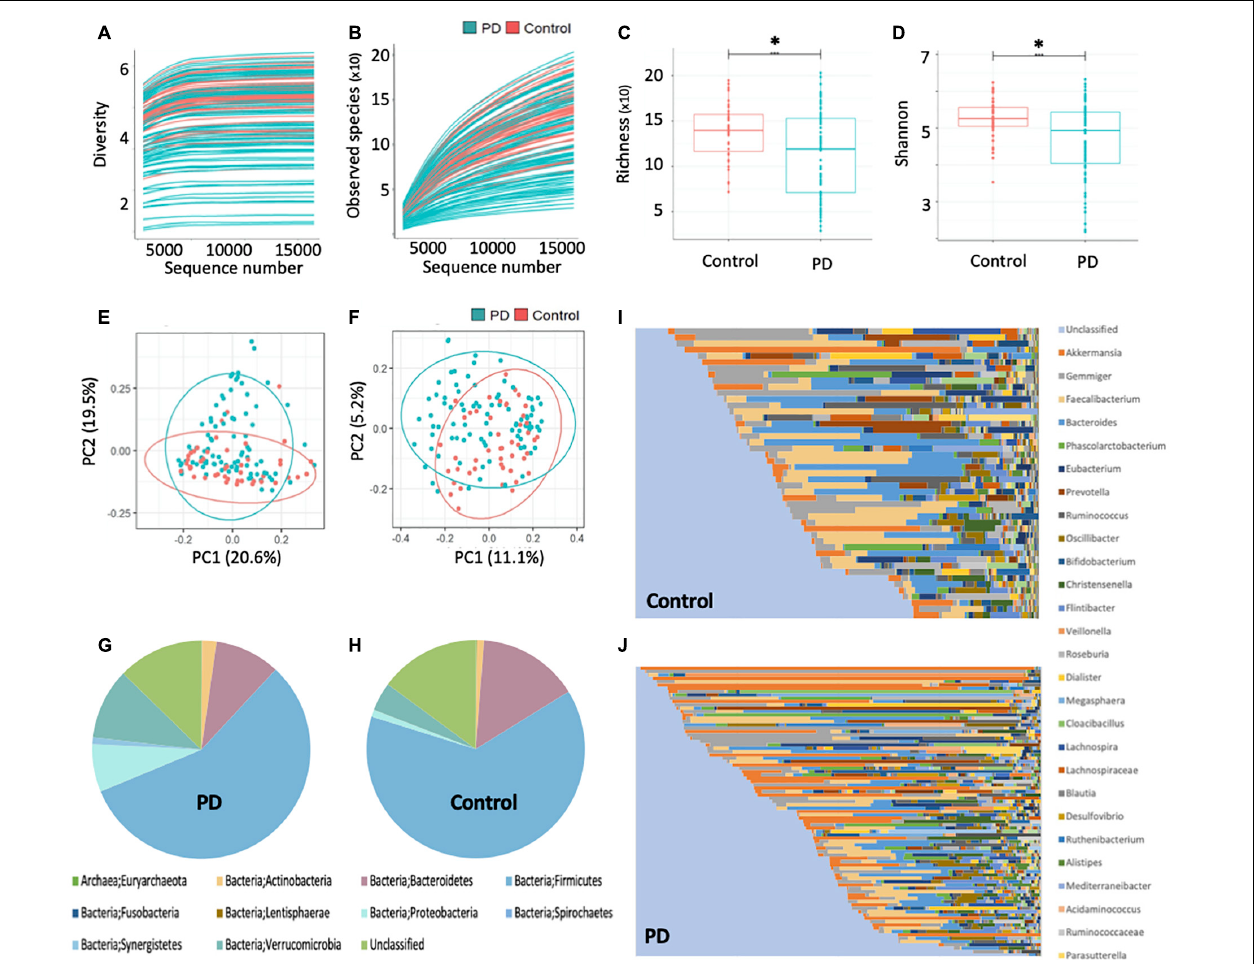
FIGURE 1 | Gut microbiota sequencing overview in controls and PwP. (A) Rarefaction curve based on Shannon diversity index. (B) Rarefaction curve based on species richness index. (C) Comparison of alpha diversity based on species richness index and (D) Shannon diversity index, between PwP and control cohorts using ANOVA. (E) Principal coordinates analysis based on weighted and (F) unweighted UniFrac distance metrics. (G) Relative abundance of bacterial phyla in PwP and (H) control cohorts. (I) Relative abundance of bacterial genera in control and (J) PwP cohorts. Relative abundance was calculated using OTU values, and each color represents a different bacterial taxon. ∗ indicates p < 0.001. Figures were created using R v. 4.0.4 and Microsoft